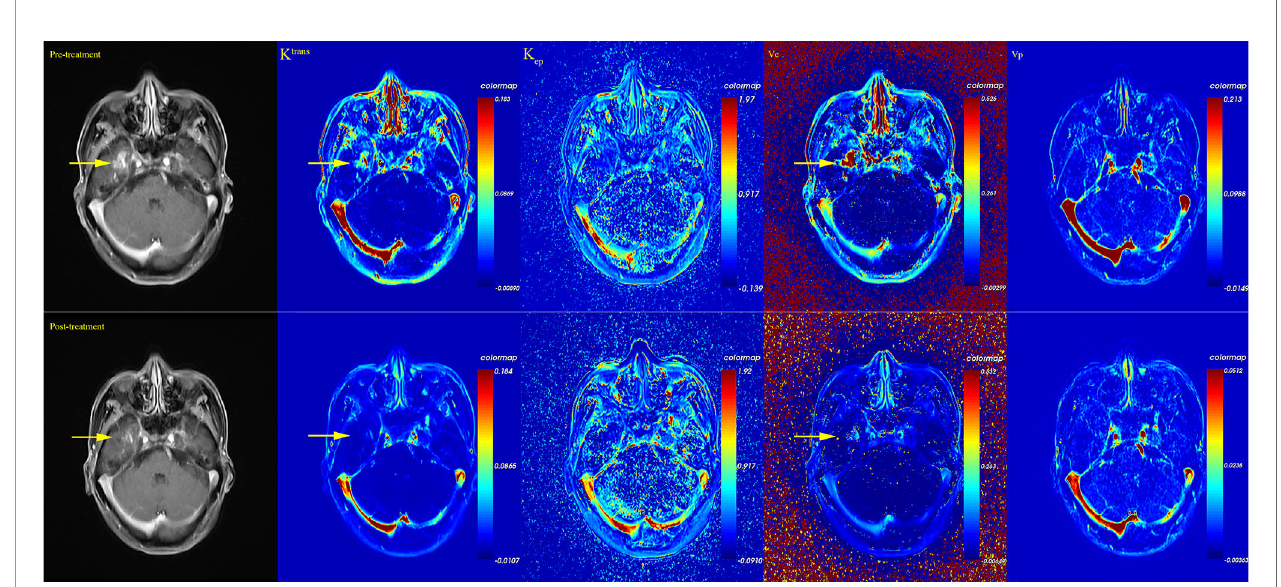
FIGURE 3 | Pseudo-color map of DCE-derived parameters of one patient before and after bevacizumab treatment. After bevacizumab, a decrease of RN enhancement and a decrease of K trans and v e level were